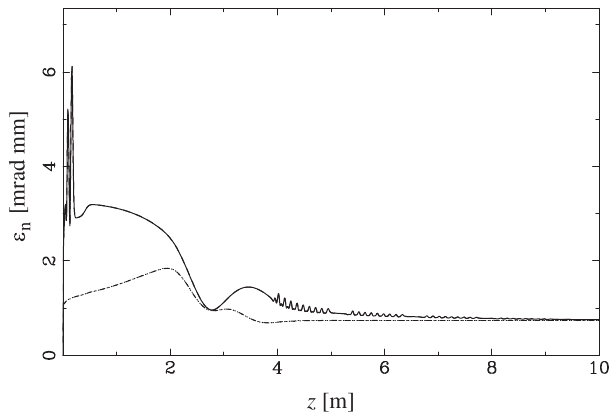
FIG. 17. Comparison of the standard emittance (solid line) and the reduced emittance (dashed line) along the injector beam line.